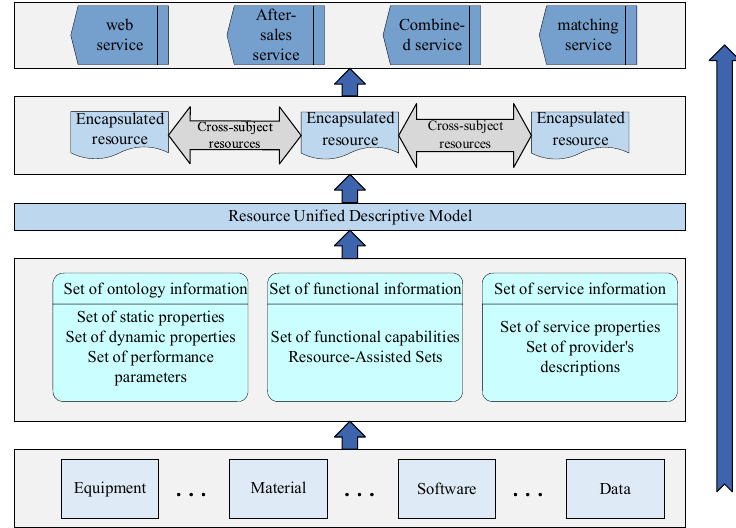
Figure 2. Unified descriptive framework.